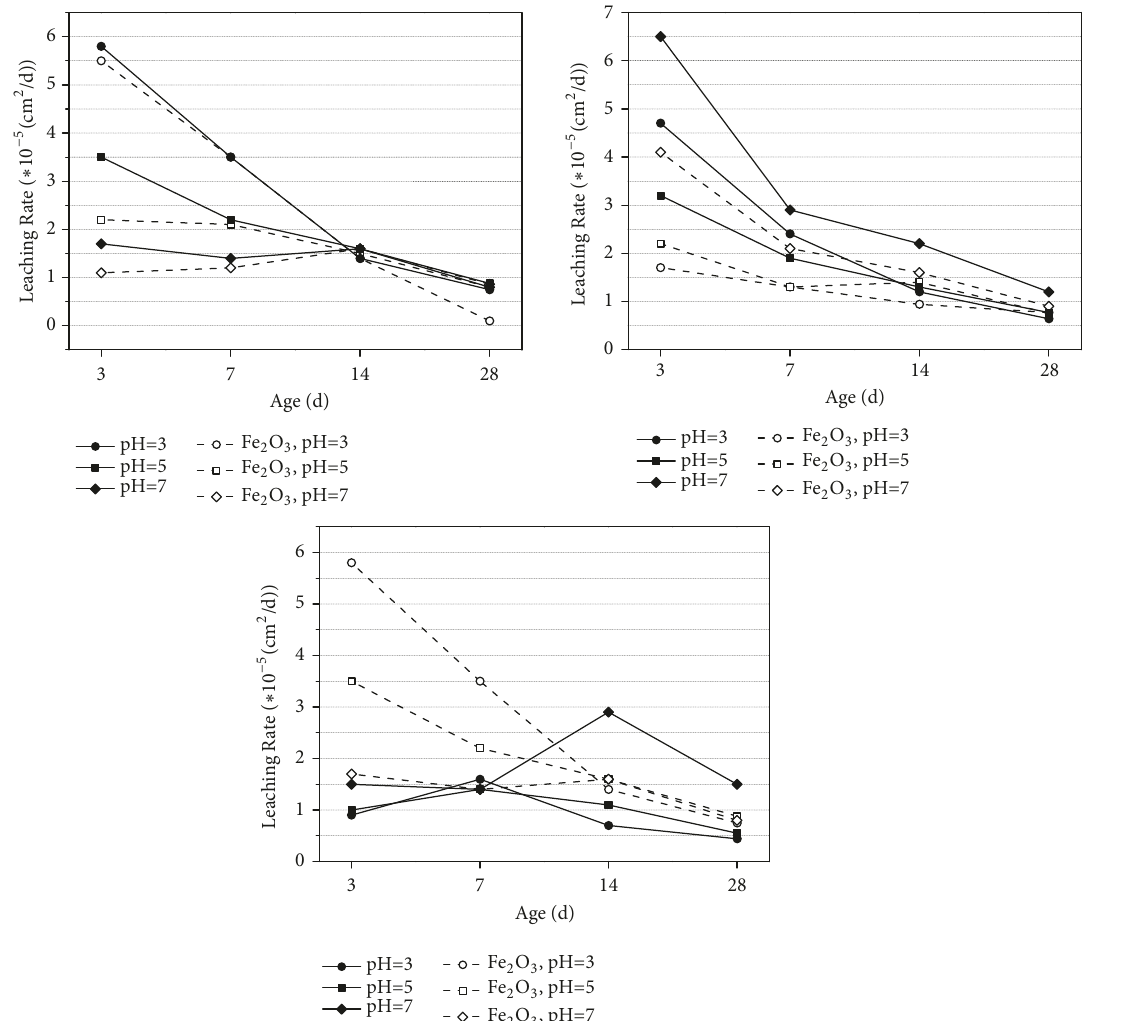
Figure 12: Leaching rate of Cs + ( A unsintered samples, B 900 ∘ C sintered samples, C 1000 ∘ C sintered samples).